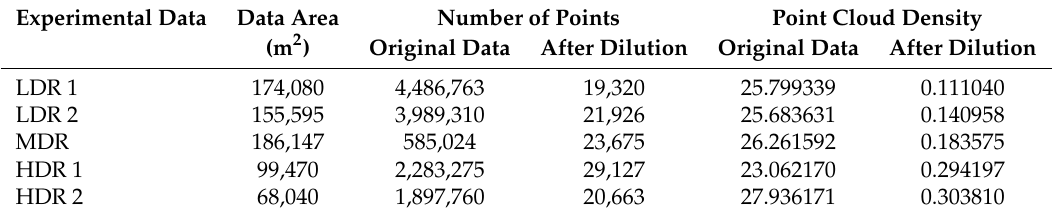
Table 2. Experimental data information. LDR, low-density region; MDR, medium-density region; HDR, high-density region.